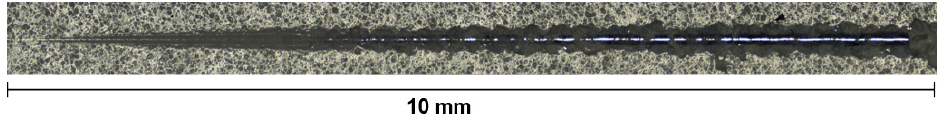
Figure 7. Optical microscope image of the scratched “white” protective coating (Olympus, objective, with 20× magnification, aperture of 0.4).